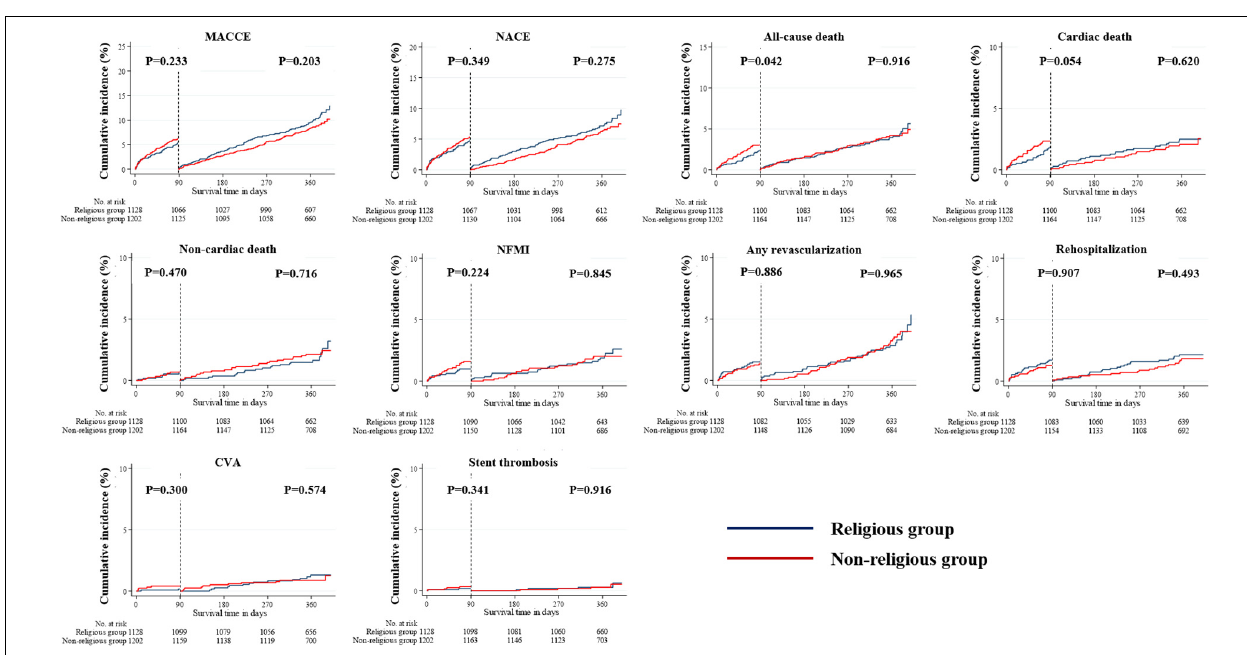
FIGURE 6 | Incidences of primary and secondary clinical outcomes for all patients in a landmark analysis between 90 days and 1 year (before PSM- or IPTW-adjusted analysis). The figure shows the Kaplan–Meier curves for the cumulative event rates according to their religious faith. IPTW, inverse probability of treatment weighting; PSM, propensity score